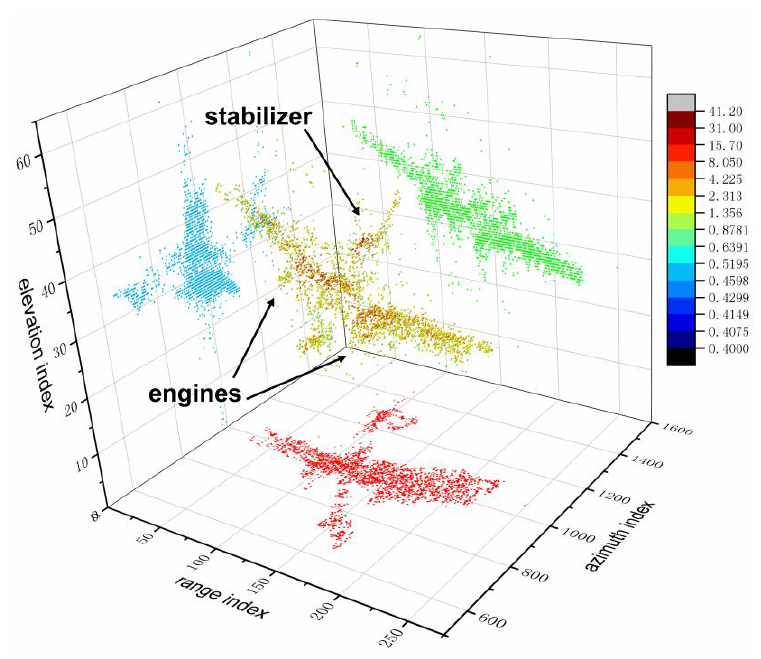
Figure 10. 3D reconstruction results of airplane with Ku band array ISAR system.